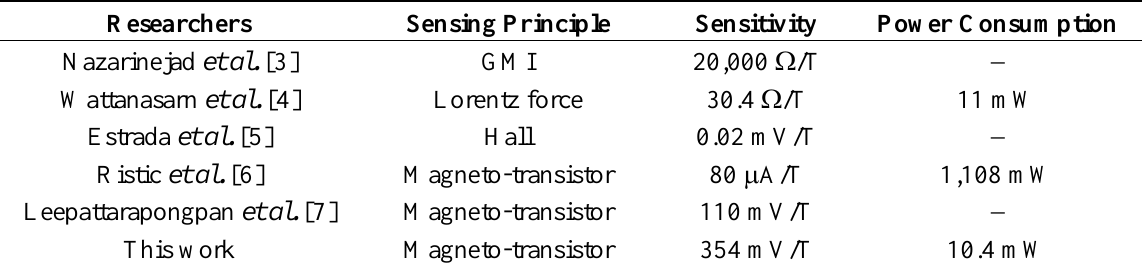
Table 1. Properties of magnetic sensors for this work and the related